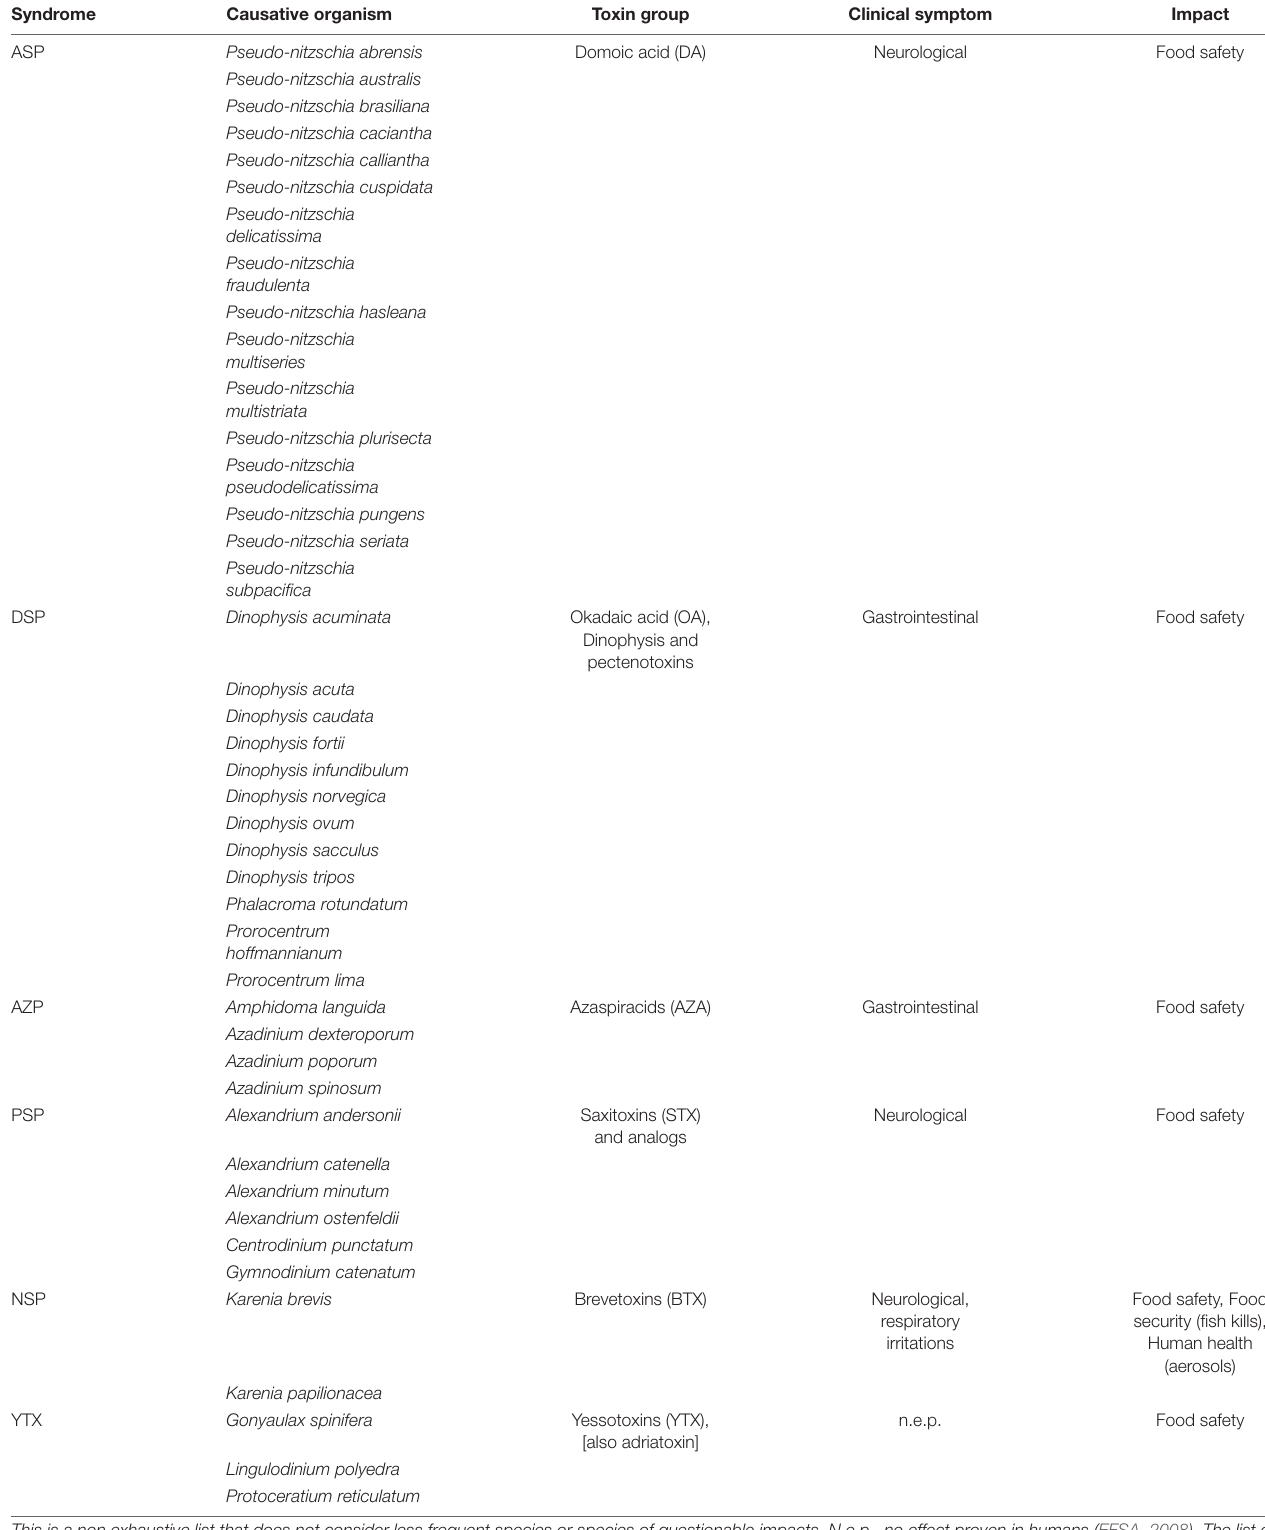
TABLE 2 | Main toxification syndromes and main associated species